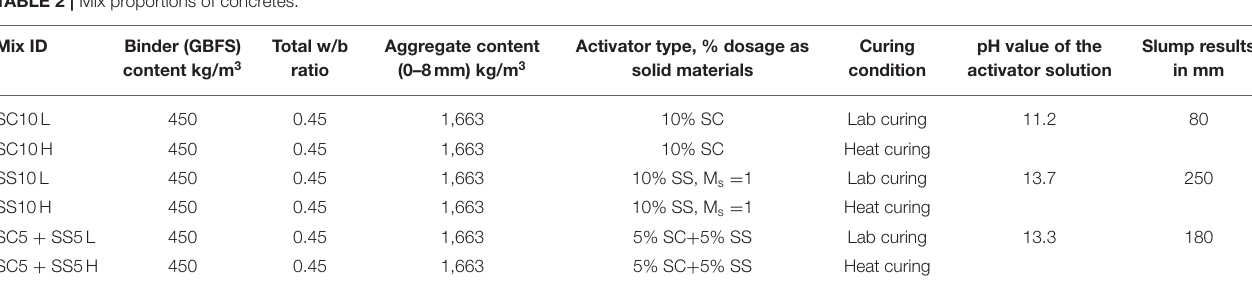
TABLE 2 | Mix proportions of concretes.